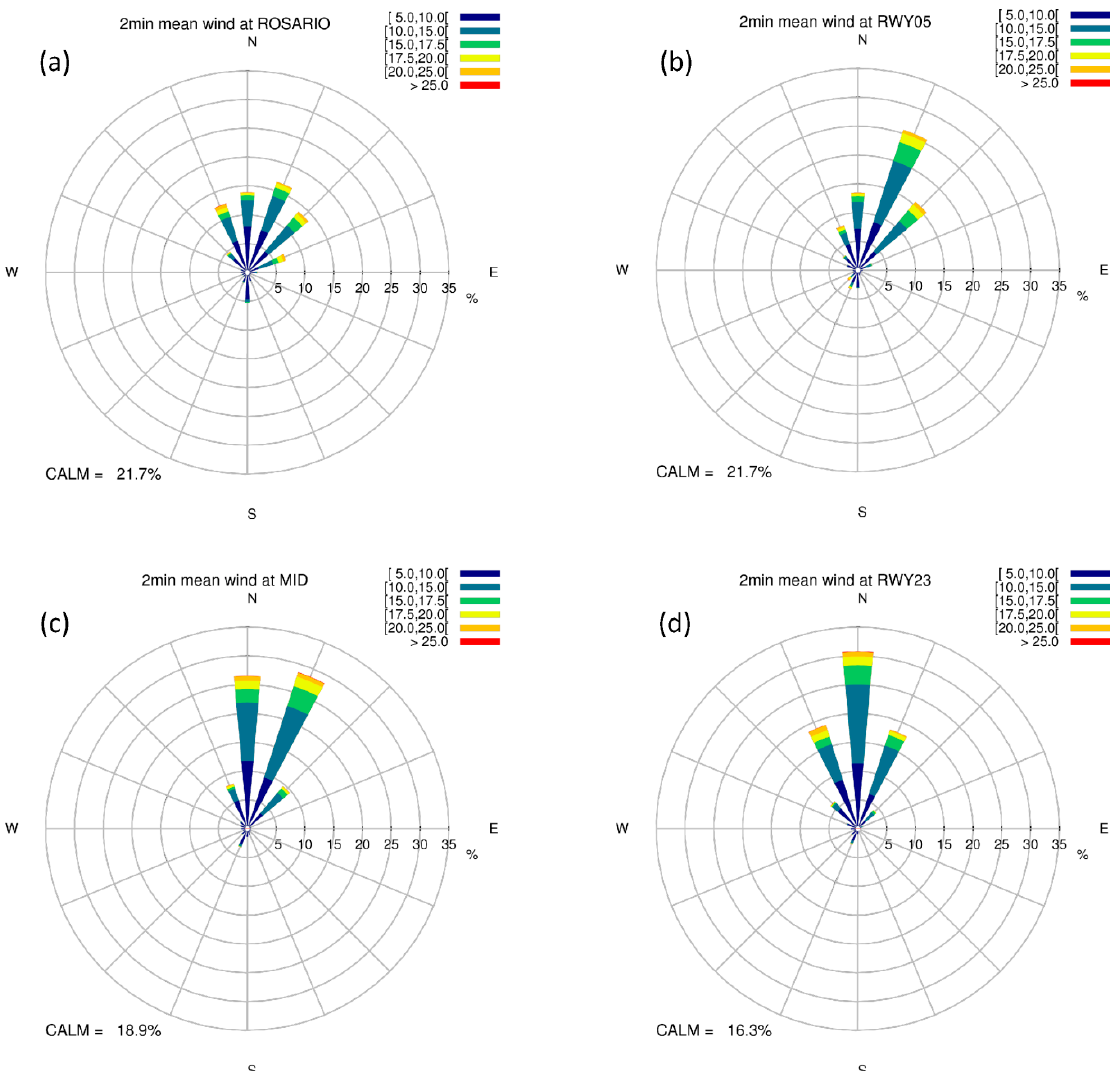
Figure 4. Wind roses screening the relative frequencies of occurrence (in percent) of the average 2-min wind speed at 10-m height, over the summertime period (April–September), at Rosario (RS) ( a ) and at three sites at the Madeira Airport: RWY05 ( b ), MID ( c ) and RWY23 ( d ). Six wind speed classes (in kt) are also shown (cf. legend), as well as the percent of calm (<5 kt) events.